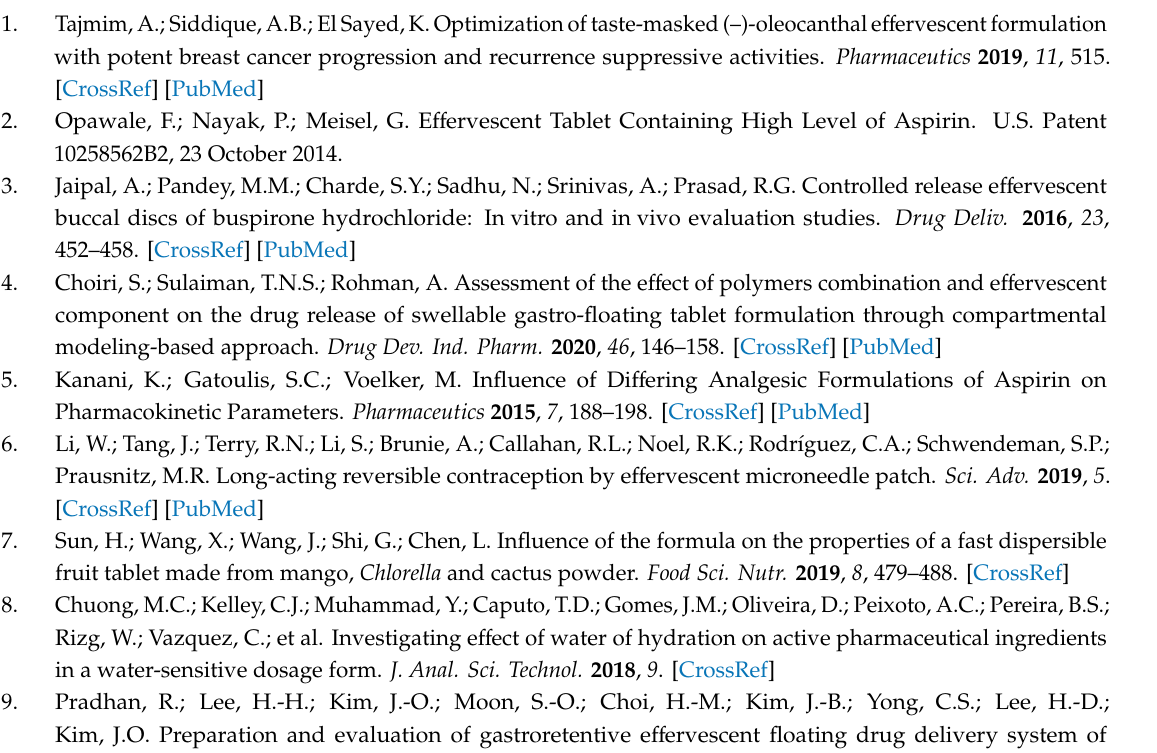
Figure S1: Optical microscopy photomicrographs of the longitudinal and transversal view of the filaments at a 30 × magnification, Figure S2: DSC curve of paracetamol as supplied and the fresh extrudates. Dark blue dotted lines show citric acid degradation and light blue dotted lines show sodium bicarbonate